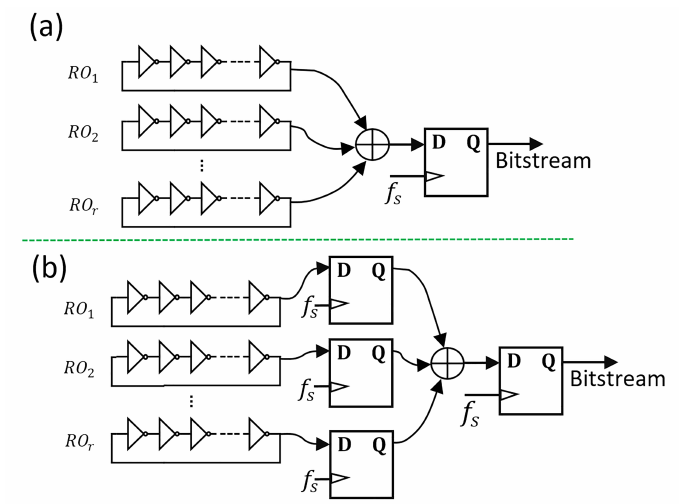
Figure 1. RO-based TRNG. ( a ) Original circuit in [1]; ( b ) improved circuit in [2]. The degradation of bitstream randomness is highly relevant to the status of ROs.